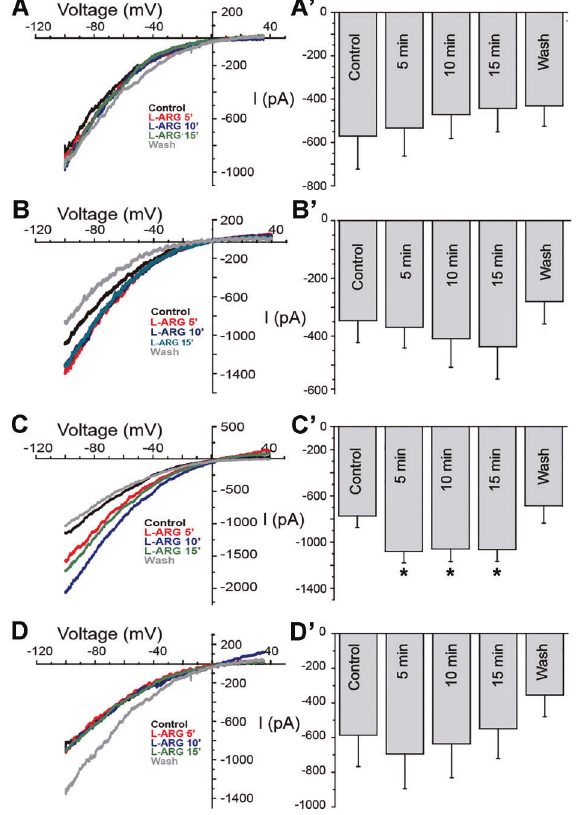
Figure 3. Effects of different concentrations of L-arginine on purinergic currents. A , B , C and D , Representative I (cid:2) V plots for the ATP-elicited currents after the treatment with 10 m M ( A ), 100 m M ( B ), 300 m M ( C ), and 500 m M ( D ) L-arginine for 5 (red), 10 (blue), and 15 min (green) followed by 15 min (gray) washing. A ’ (n=9 cells), B ’ (n=8 cells), C ’ (n=7 cells), and D ’ (n=8 cells) show the means ± SE of the current values at – 70 mV for each group. Note the signi fi cant increase in the amplitude of the currents only with 300 m M L-arginine. *P p 0.05, n=7 cells (ANOVA and Tukey post-test).